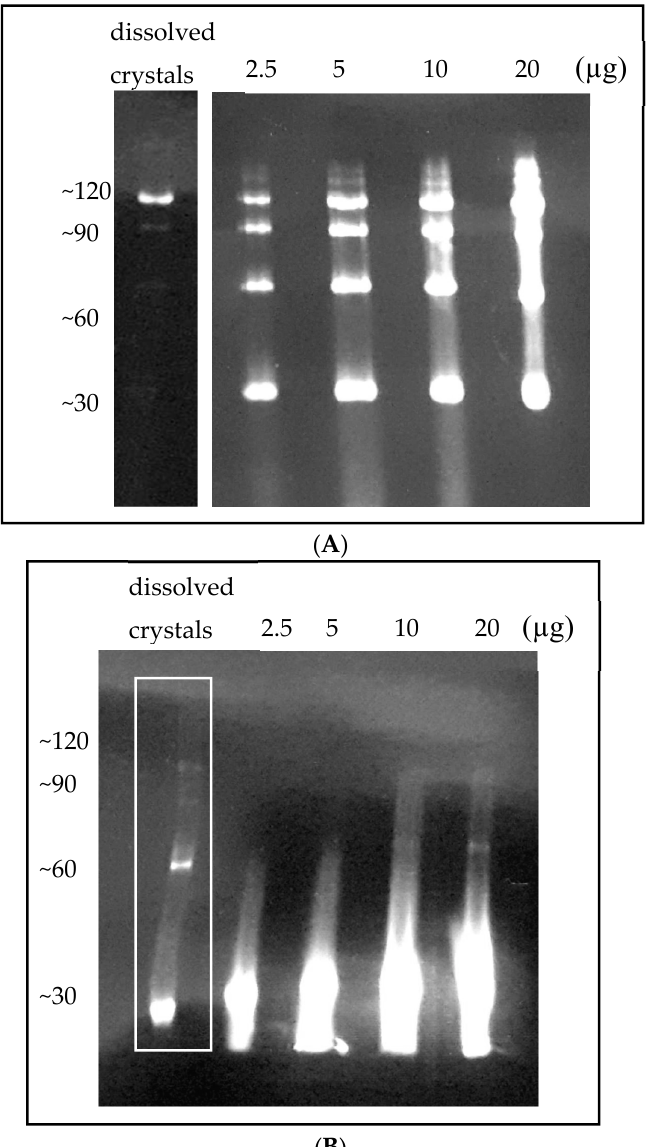
Figure 5. Native PAGE of wt and P61C hoefavidins complexed with biotin-4-fluorescein. ( A ) Upon crystallization and consequent dissolving of crystals (left panel) only the octamer is apparent. Purified P61C hoefavidin prior to crystallization (right panel) at different amounts (µg) of protein shows a heterogeneous profile of oligomers ranging from dimers to octamers. ( B ) Dissolved crystals of wt hoefavidin (left lane, indicated in a white rectangle) clearly show that although they are octamers in the crystalline state, they disintegrate into several types of oligomers upon binding of the fluorescent biotin. The other lanes show the pre-crystallized wt hoefavidin at different amounts (µg).